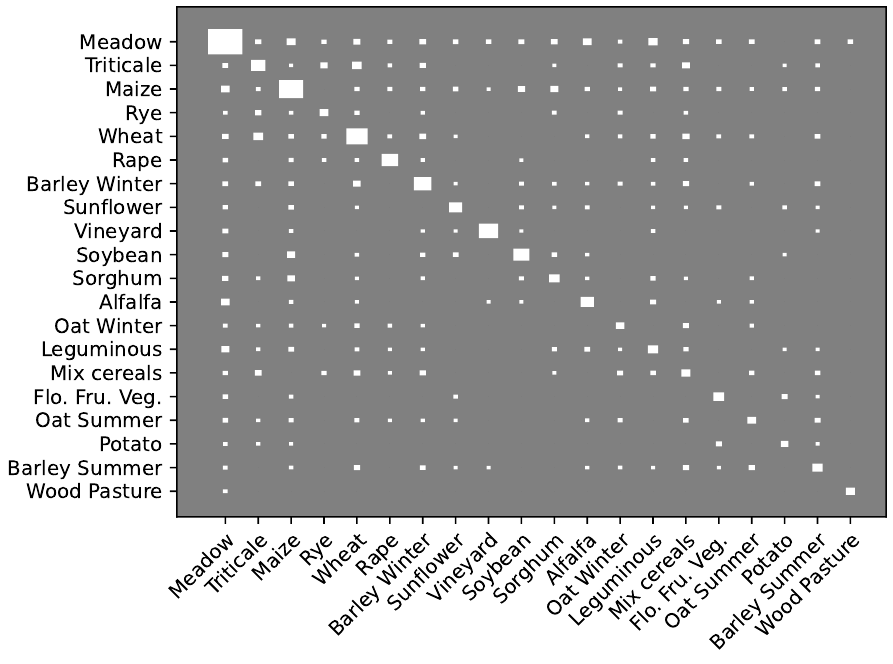
for the year 2020. The area M dec